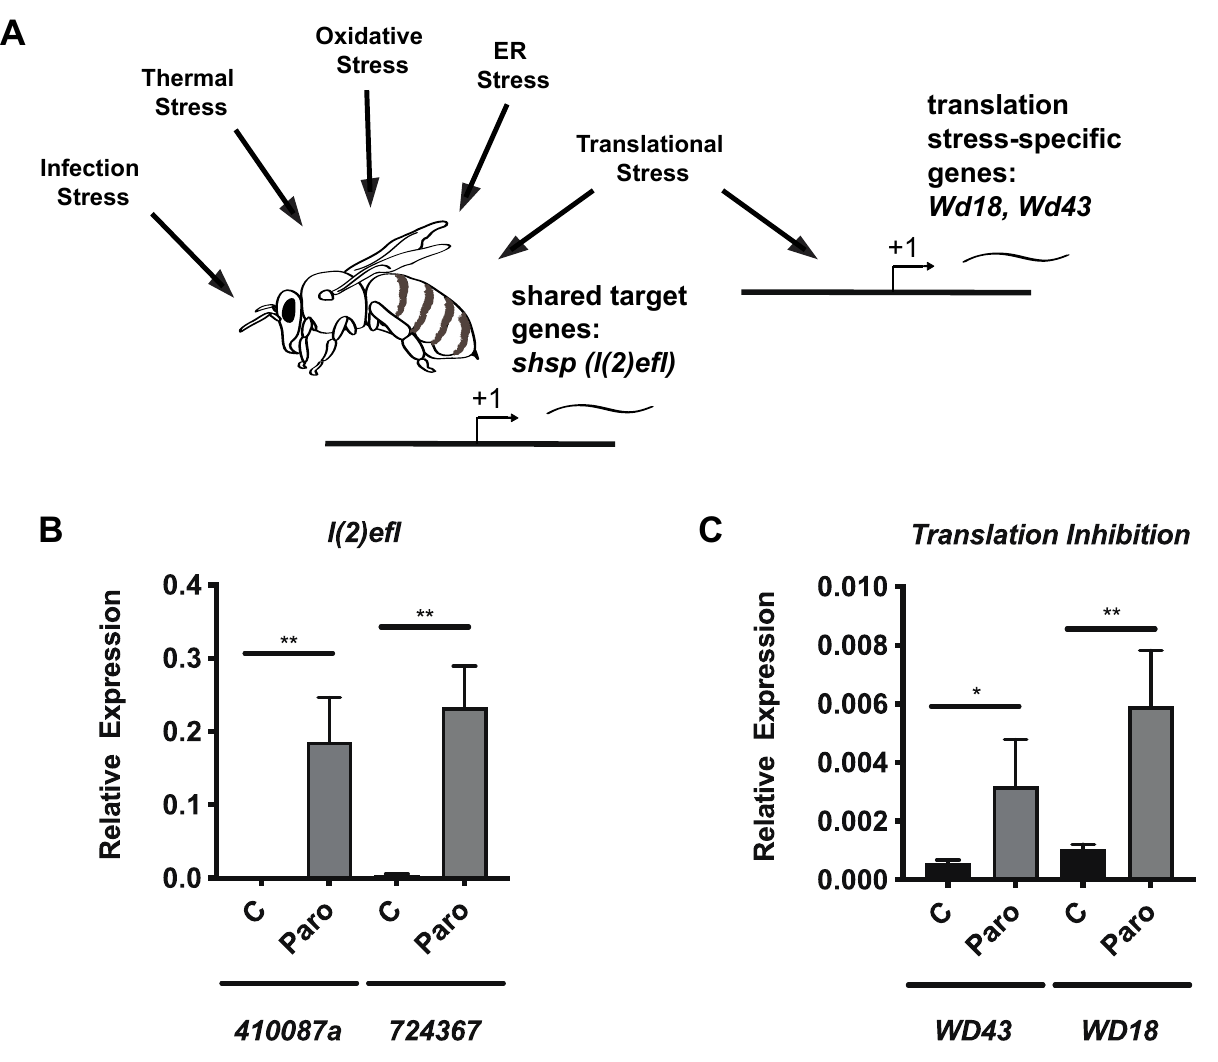
Figure 4. Paromomycin impacts stress biomarker gene expression at doses that are effective at reducing V. ceranae infection intensity . Schematic showing diverse stressors that induce the l(2)efl family of shsp genes and the translational stress-specific ribosome biogenesis genes WD43 and WD18 ( A ). Transcript levels of the l(2)efl genes 724367 and 410087a ( B ) and the ribosome biogenesis genes WD43 and WD18 ( C ) relative to the β -actin in midgut tissue from adult bees captured at the landing board and fed with a sucrose solution alone ( C , n = 10) or with 1 mg/mL of paromomycin (Paro, n = 10). Means ± SEM are shown and represent the expression values of the genes of interest, calculated using the 2 ( − Δ CT) method for individual bees. Statistical significance is noted as * for p < 0.05 and ** for p < 0.01.